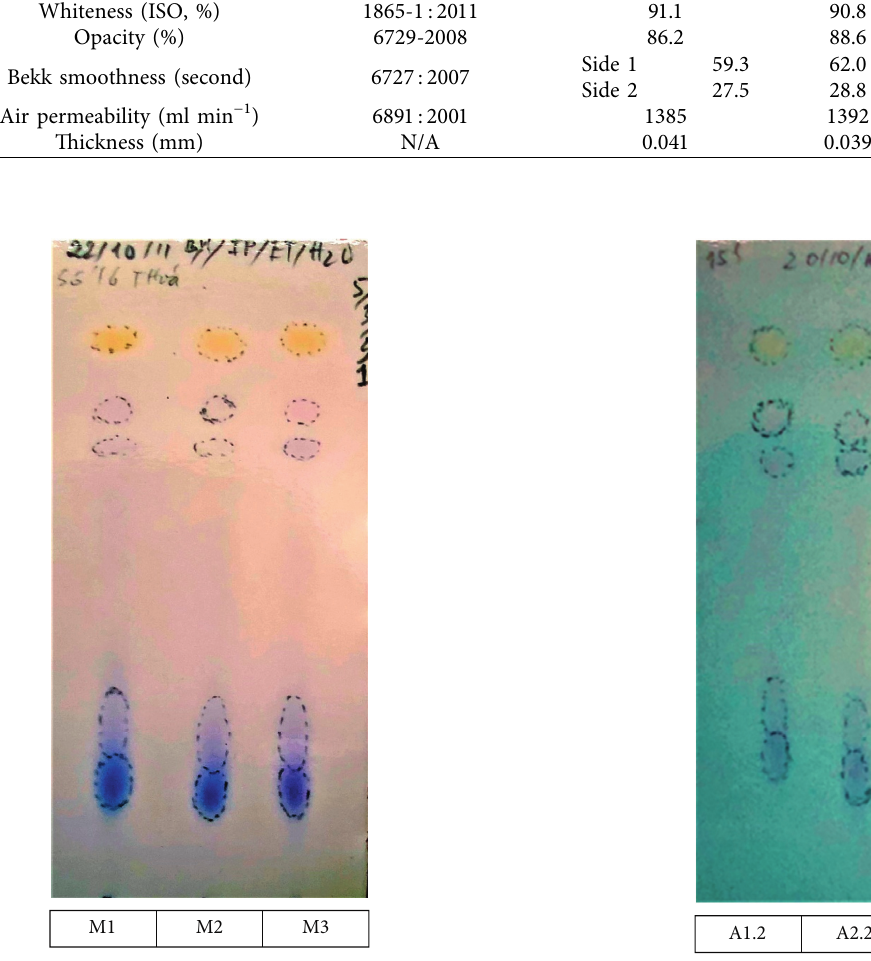
Figure 3: HPTLC of reference samples A1.2, A2.2, and A3.2 (39- month-old) developed in system A—butanol/isopropanol/ethanol/ water (5:3:2